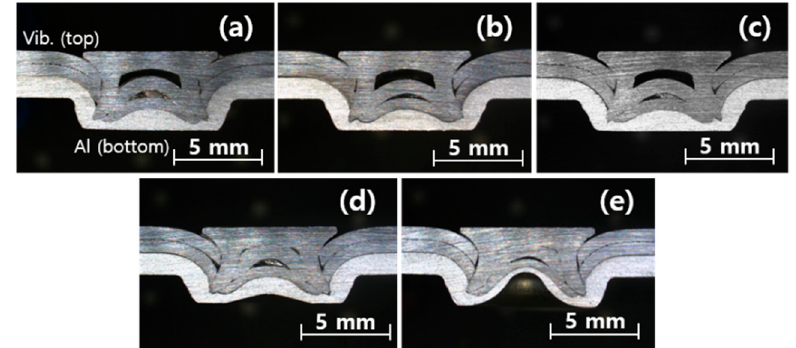
Figure 6. Cross-sectional images for SPR joint of vibration-damping steel (top) and Al5052-H32 (bottom) with respect to SPR die type. ( a ) Type A1 die, ( b ) type A2 die, ( c ) type A3 die, ( d ) type B die, and ( e ) type C die.